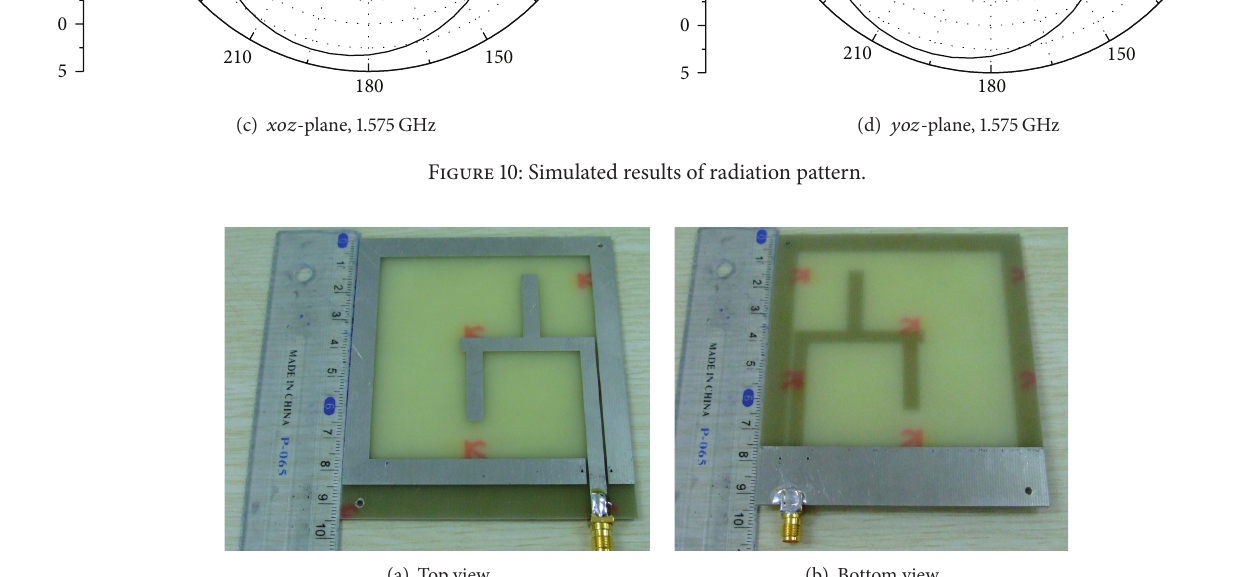
Figure 11: Prototype of